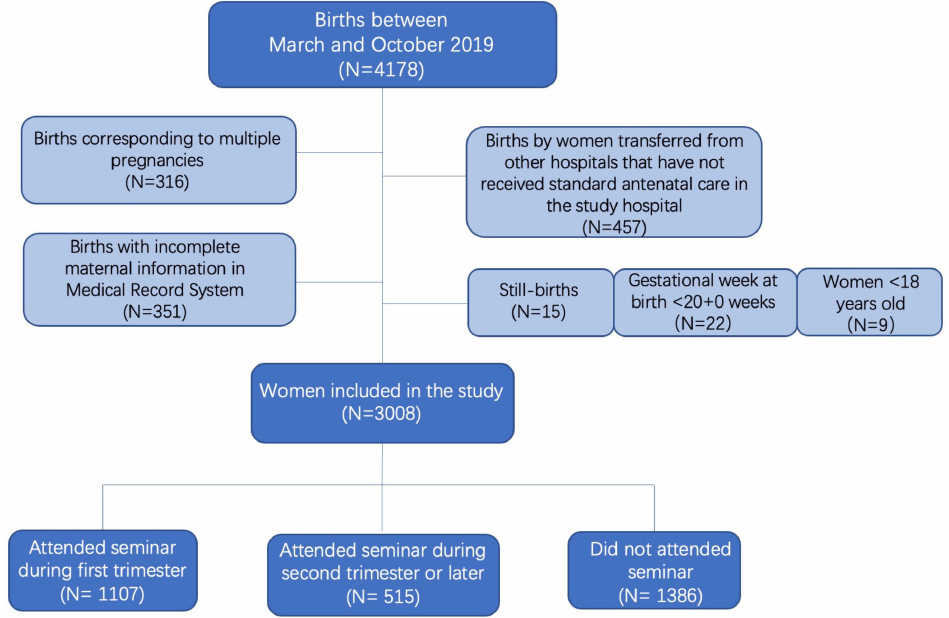
Figure 1. Study cohort